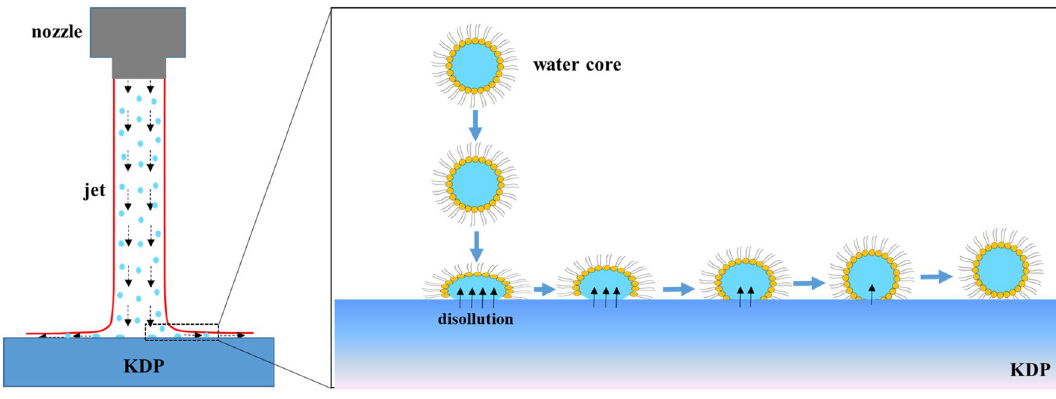
Figure 9. The schematic illustration of removal mechanism of